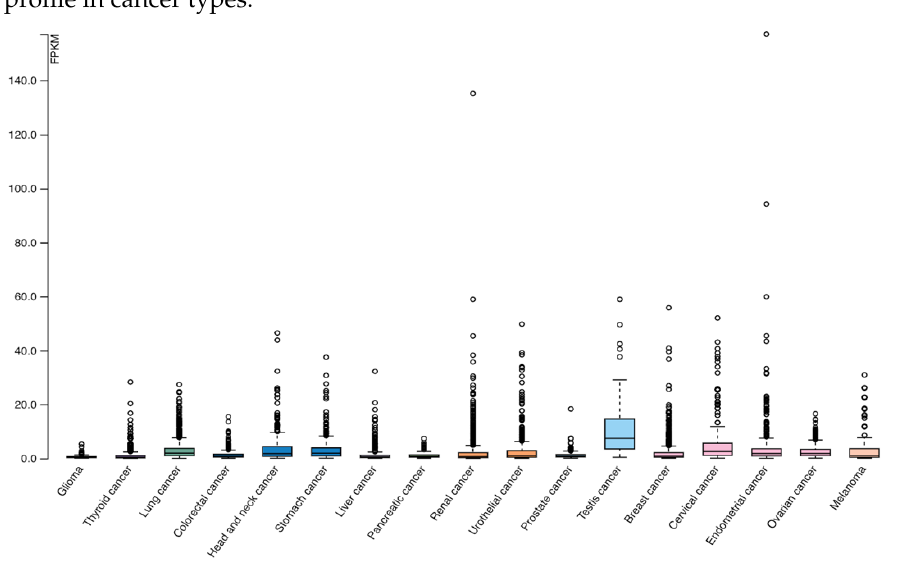
Figure 4. RNA-seq data across the 17 cancer types are presented as median FPKM (number of fragments per kilobase exon per million reads), generated by The Cancer Genome Atlas (TCGA). The cancer tissue RNA category is calculated based on mRNA expression levels in all 17 cancer tissues and includes enriched cancer tissues, enriched cancer groups, amplified cancer tissues, expressed in all, mixed and undetected. Normal distribution across the dataset is visualized using box plots, shown as median and 25th and 75th percentiles. Points are displayed as outliers if they are above or below 1.5 times the interquartile range. (Image credit: Human Protein Atlas, www.proteinatlas.org. Image available at the following URL: v21.proteinatlas.org/ENSG00000089692-LAG3/pathology, accessed on 8 August